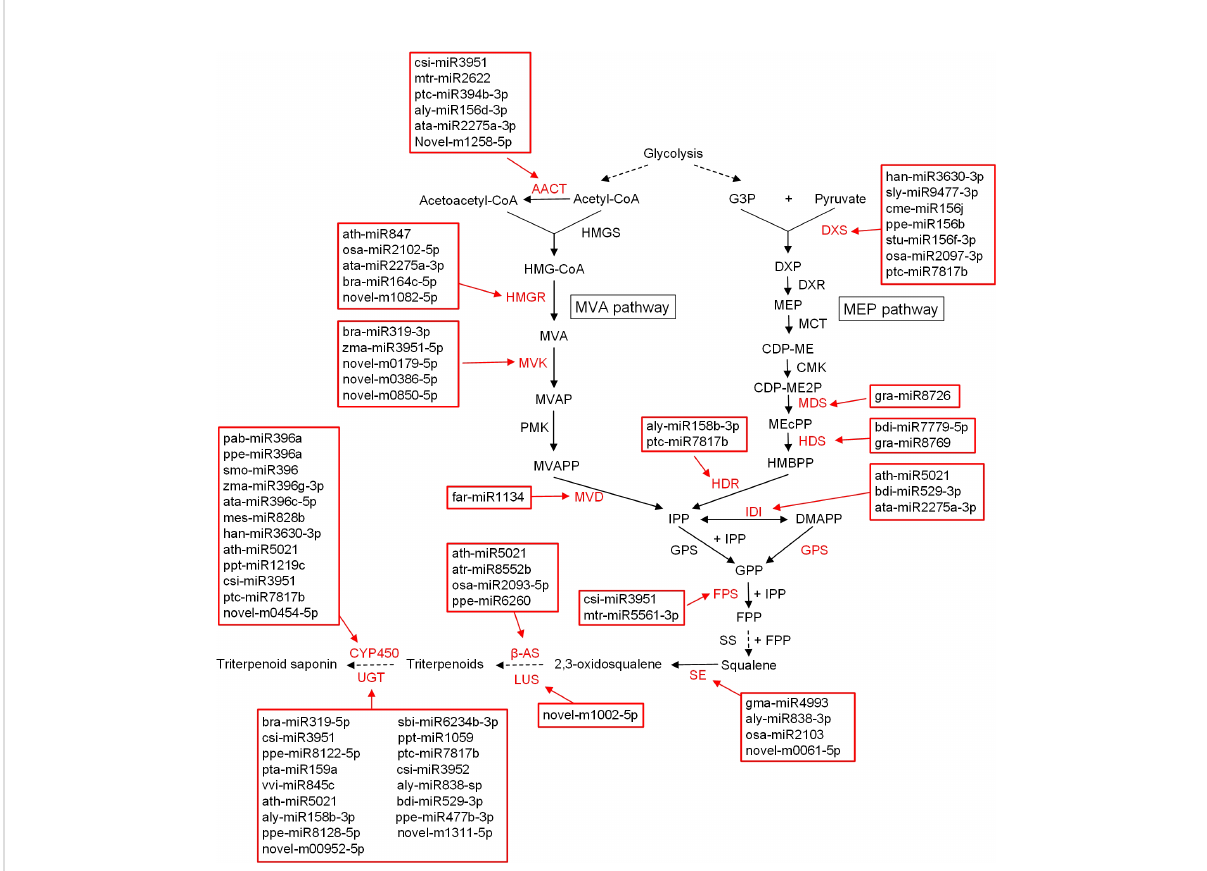
FIGURE 4 Hypothetical model of miRNAs regulation in triterpenoid biosynthesis pathway. AACT, acetyl-CoA C-acetyltransferase; HMGS, 3-hydroxyl-3- methylglutaryl-CoA synthase; HMG-CoA, 3-hydroxy-3-methylglutaryl-CoA; HMGR, 3-hydroxyl-3-methylglutaryl-CoA reductase; MVA, mevalonate; MVK, mevalolate kinase; MVAP, 5-metholvalic acid phosphoric; PMK, phosphoric acid valate kinase; MVAPP, 5-metholvalic acid pyrophosphoric acid; MVD, 5-hydroxyvalerate decarboxylase; G3P, 3-glyceraldehyde phosphate; DXS, 1-deoxy-D-xylulose-5-phosphate synthetase; DXP, 1-deoxy-D-xylulose-5-phosphate; DXR, 1-deoxy-D-xylulose-5-phosphate reductoisomerase; MEP, 2-C-methyl-D-erythritol- 4-phosphATE; MCT, 4-cytidine diphosphate-2-C-methyl-D-erythritol synthetase; CDP-ME, 4-cytidine diphosphate-2-C-methyl-D-erythritol; CMK, 4-cytidine diphosphate-2-C-methyl-D-erythritol kinase; CDP-ME2P, 4-cytidine diphosphate-2-C-methyl-D-erythritol-2-phosphate; MDS, 2-C-methyl-D-erythritol-2,4-cyclic phosphate synthetase; MEcPP, 2-C-methyl-D-erythritol-2,4-cyclic phosphate; HDS, 4-hydroxy-3- methylbut-2-enyl diphosphate synthase; HMBPP, 4-hydroxy-3-methylbut-2-enyl pyrophosphate; HDR, 4-hydroxy-3-methylbut-2-enyl diphosphate reductases; IDI, isopentenyl pyrophosphate isomerase; IPP, isopentenyl pyrophosphate; DMAPP, dimethylallyl pyrophosphate; GPP, geranyl pyrophosphate; GPS, geranylpyrophosphate synthetase; FPS, farnesyl pyrophosphate synthetase; FPP, farnesyl pyrophosphate; SS, squalene epoxidase; b -AS, beta-amyrin synthase; LUS, lupeol synthase; CYP450, cytochrome P450; UGT, uridine diphosphate-dependent